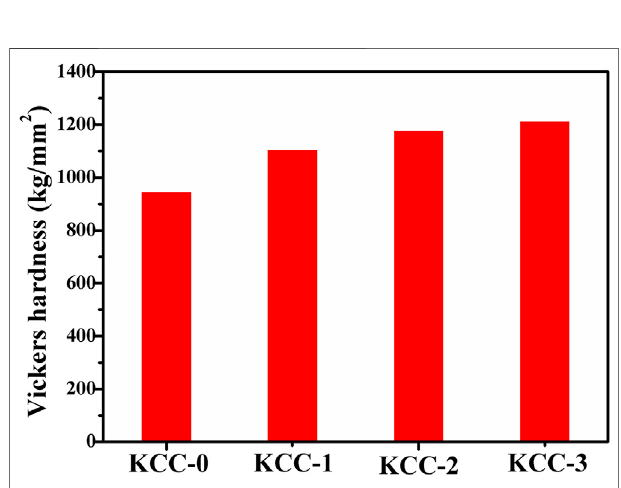
FIGURE 7 | Vickers hardness of the kaolin